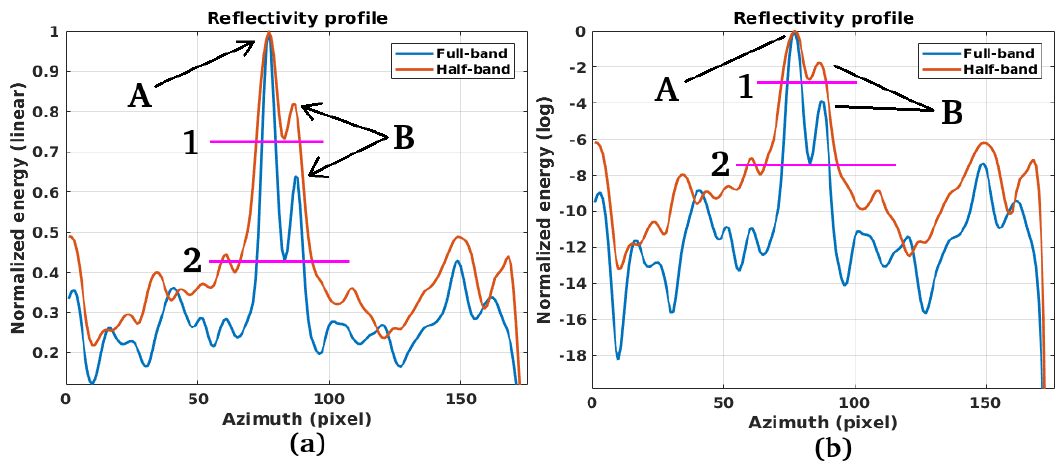
Figure 10. SAR reflectivity profiles (energy): ( a ): Full resolution. ( b ): Half